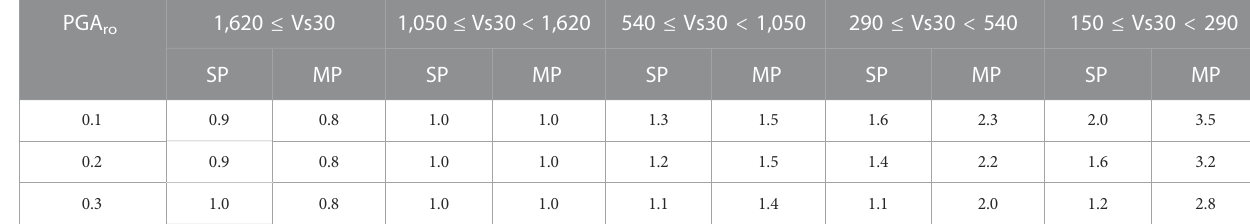
was rounded up and expressed in Roman letters. In Figure 13, outside of the square the case of under- or over-predicting the seismic intensity is reported. In the Borcherdt model-based KMA process, the accuracy